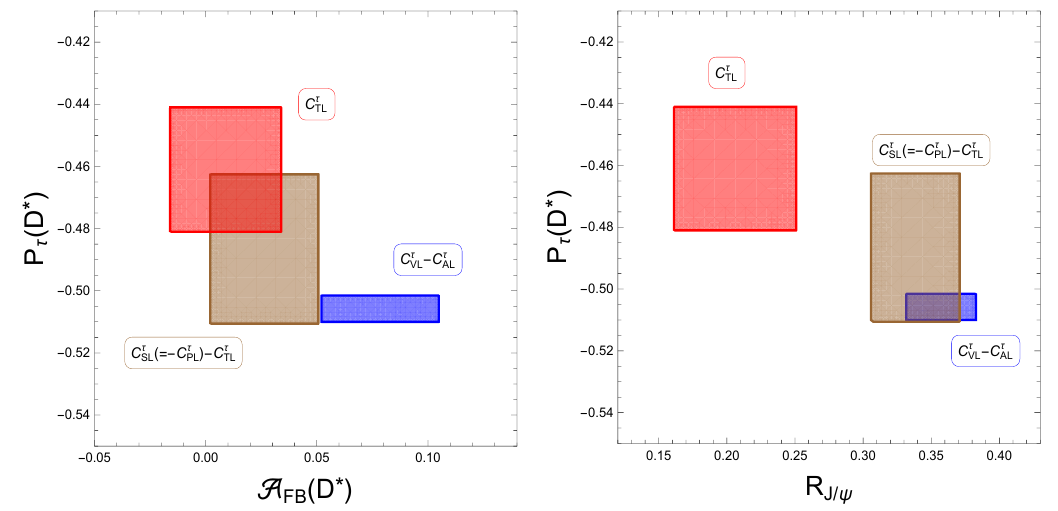
for values of the WCs that correspond to J=